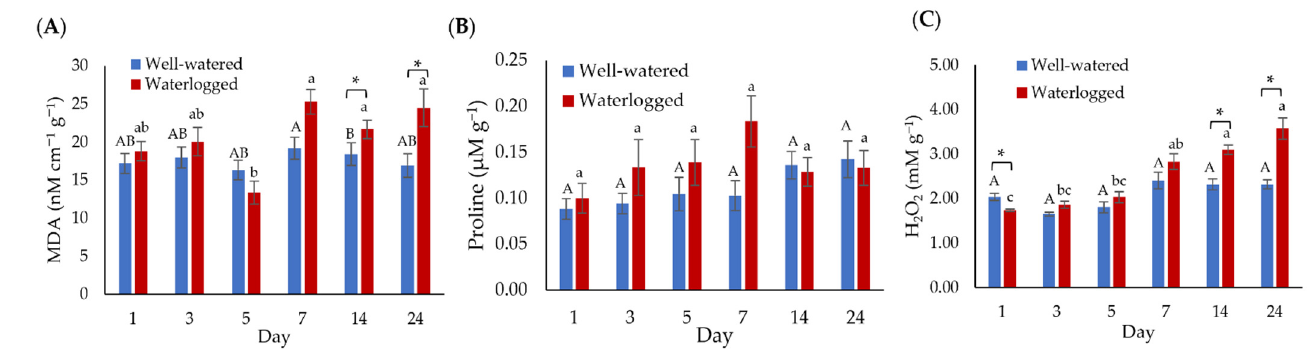
Figure 3. Proline and lipid peroxidation changes in the well-watered and waterlogged banana plants. ( A ) Malondialdehyde (MDA), ( B ) proline contents, and ( C ) hydrogen peroxide (H 2 O 2 ) of